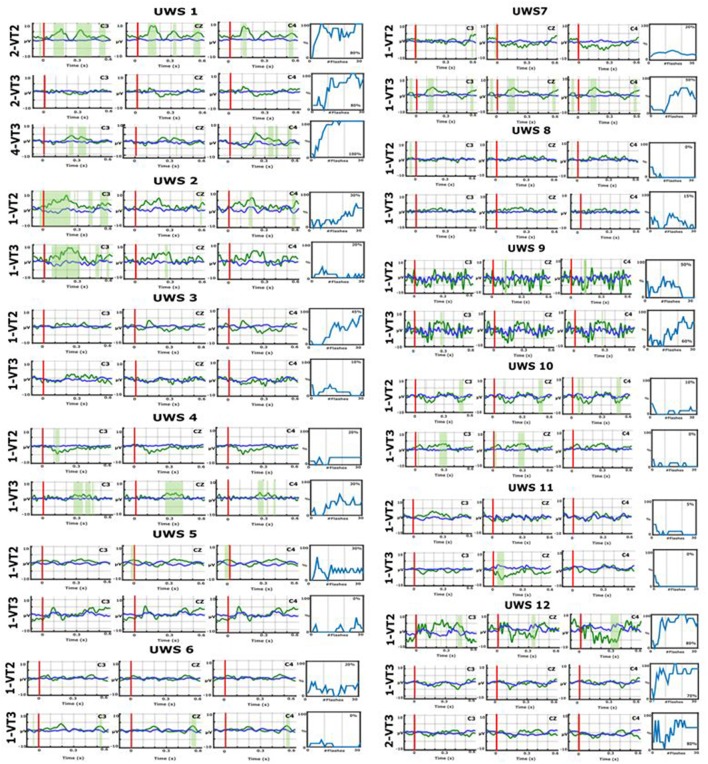
Event-related potentials (ERPs) over electrode sites C3, Cz, and C4 and BCI accuracies for VT2 and VT3 runs from all participants. The x-axes of the ERP plots present the time relative to stimulus onset, and the vertical red lines show stimulus onset at 0 ms. The blue lines reflect non-target ERPs, the green lines show target ERPs, and the green shaded areas show significant differences between these two traces. For example, in UWS1, the green shaded areas are most pronounced in the VT2 task, particularly over C3.The accuracy plots to the right of these ERPs show the resulting BCI accuracy. In each plot, the y-axis shows the % accuracy and the x-axis shows the number of trial groups (groups of eight stimuli) that were used to derive that accuracy.